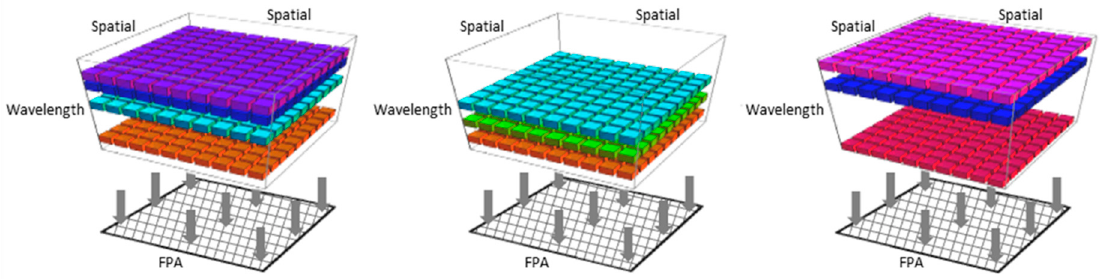
Figure 1. Spectral multiplexing. The figure represents three different examples of spectral multiplexing. Each sub-figure illustrates multiplexing of a few spectral bands onto a FPA.